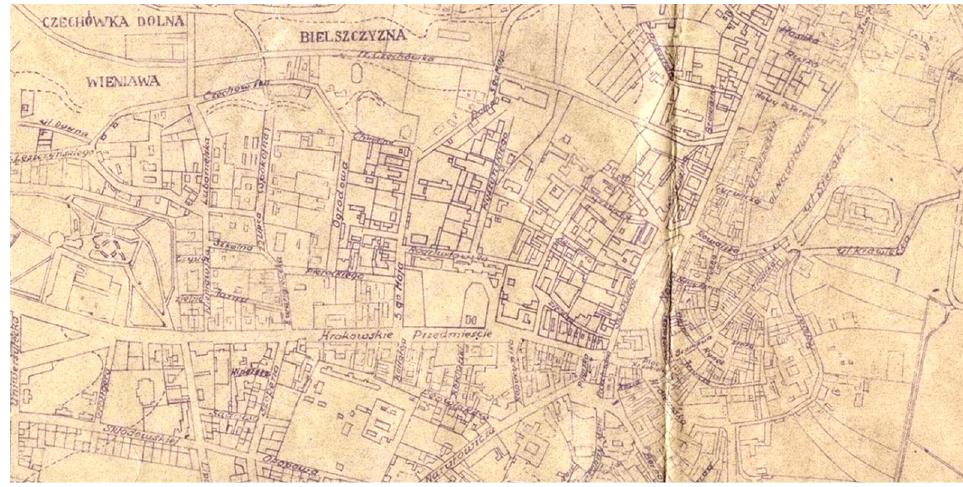
Fig. 1. A part of the city map of Lublin published in 1947 (source: Lublin, Biuro Pomiarów